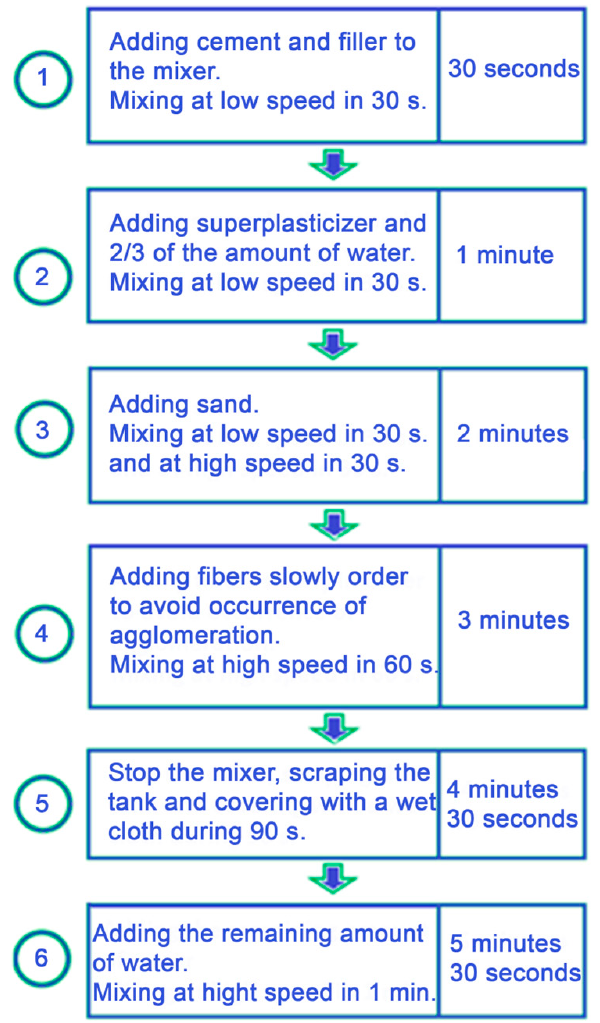
Figure 3. Mixing FRS process.